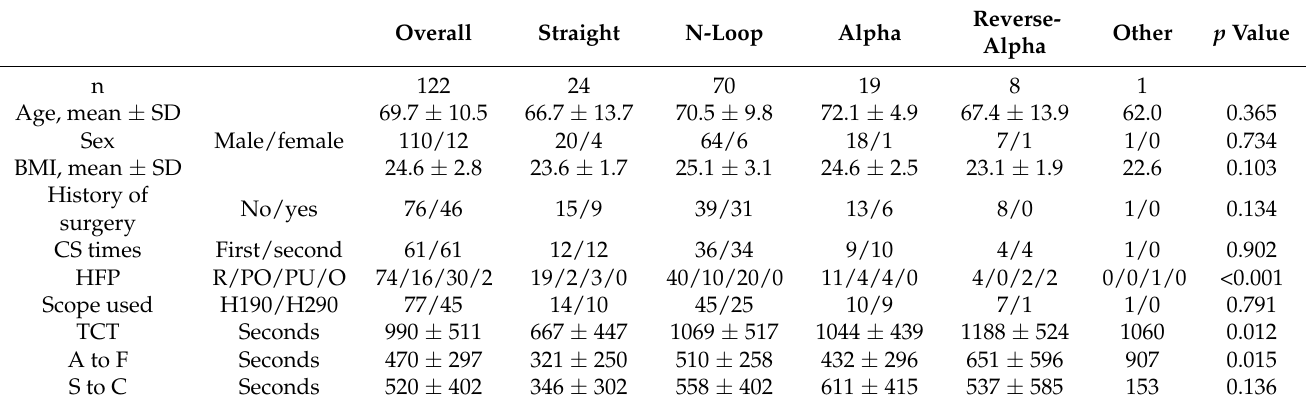
Table 2. Relationship between the pattern for passing through the sigmoid/descending colon junction, demographic characteristics, and colonoscopy